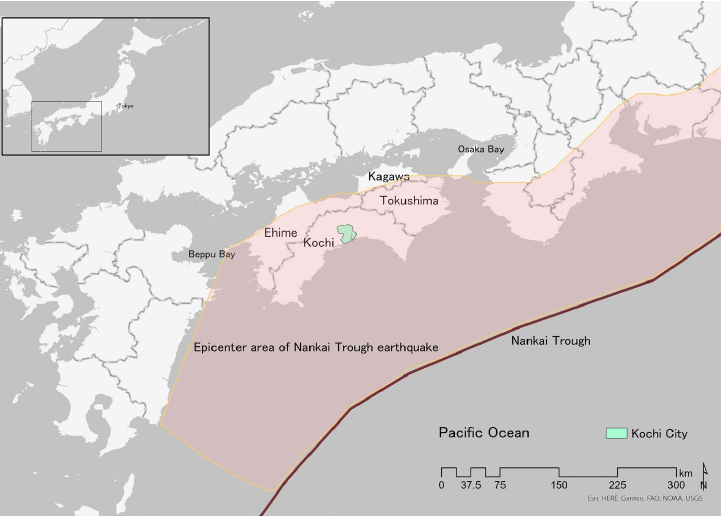
Figure 1. Location of Kochi City, Japan, the epicenter area of the Nankai Trough, and the projected region of a Nankai Trough earthquake. Gray areas represent the sea, white areas represent the land, and the gray boundary lines indicate prefectural borders. The Nankai Trough epicenter area was determined using ocean plate data [40] 2003, Hugo Ahlenius, Nordpil, Peter Bird from GitHub with reference to a paper by Bird (2003) [41]. The Nankai Trough earthquake source zone was determined by referring to Nankai Trough earthquake source data from the Japan Meteorological Agency